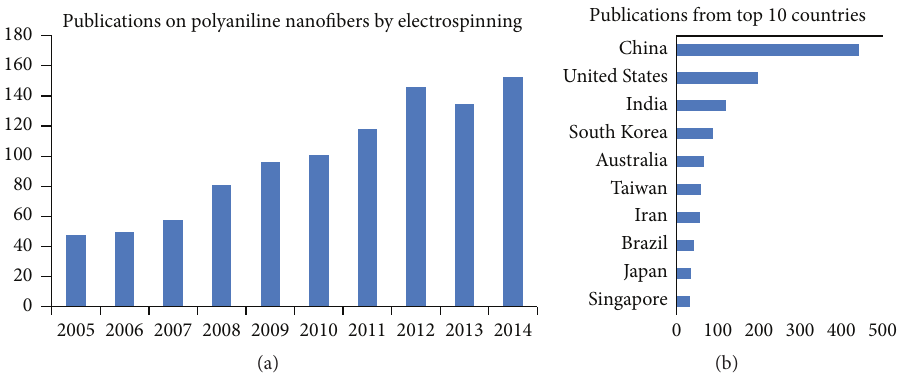
Figure 1: (a) Comparison of the annual number of scientific publications related to electrospinning polyaniline nanofibers. (b) Publication distribution around the world based on data analysis carried out using the Scopus search system with the term “polyaniline nanofibers” as of 30 March